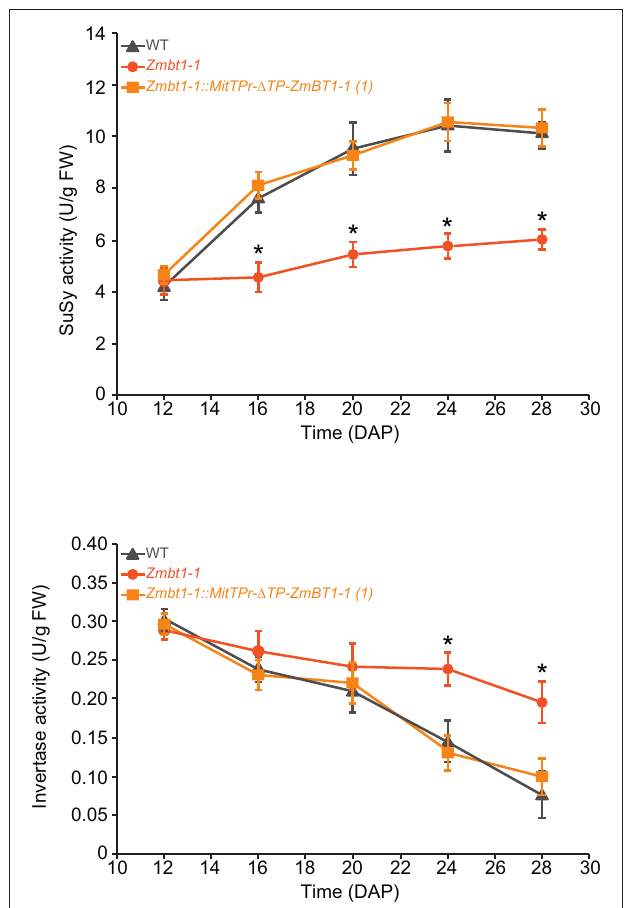
FIGURE 6 | Lack of mitochondrial ZmBT1-1 impedes down-regulation of CWI-2 expression and up-regulation of SH1 expression during endosperm development. The graphics represent total invertase and SuSy activities in WT, Zmbt1-1, and Zmbt1-1::MitTPr- 1 TP-ZmBT1-1(1) endosperms during seed development. Values represent the mean ± SD of determinations on four independent samples. Asterisks indicate significant differences based on Student’s t -tests. ( P < 0.05, Zmbt1-1 mutants vs.